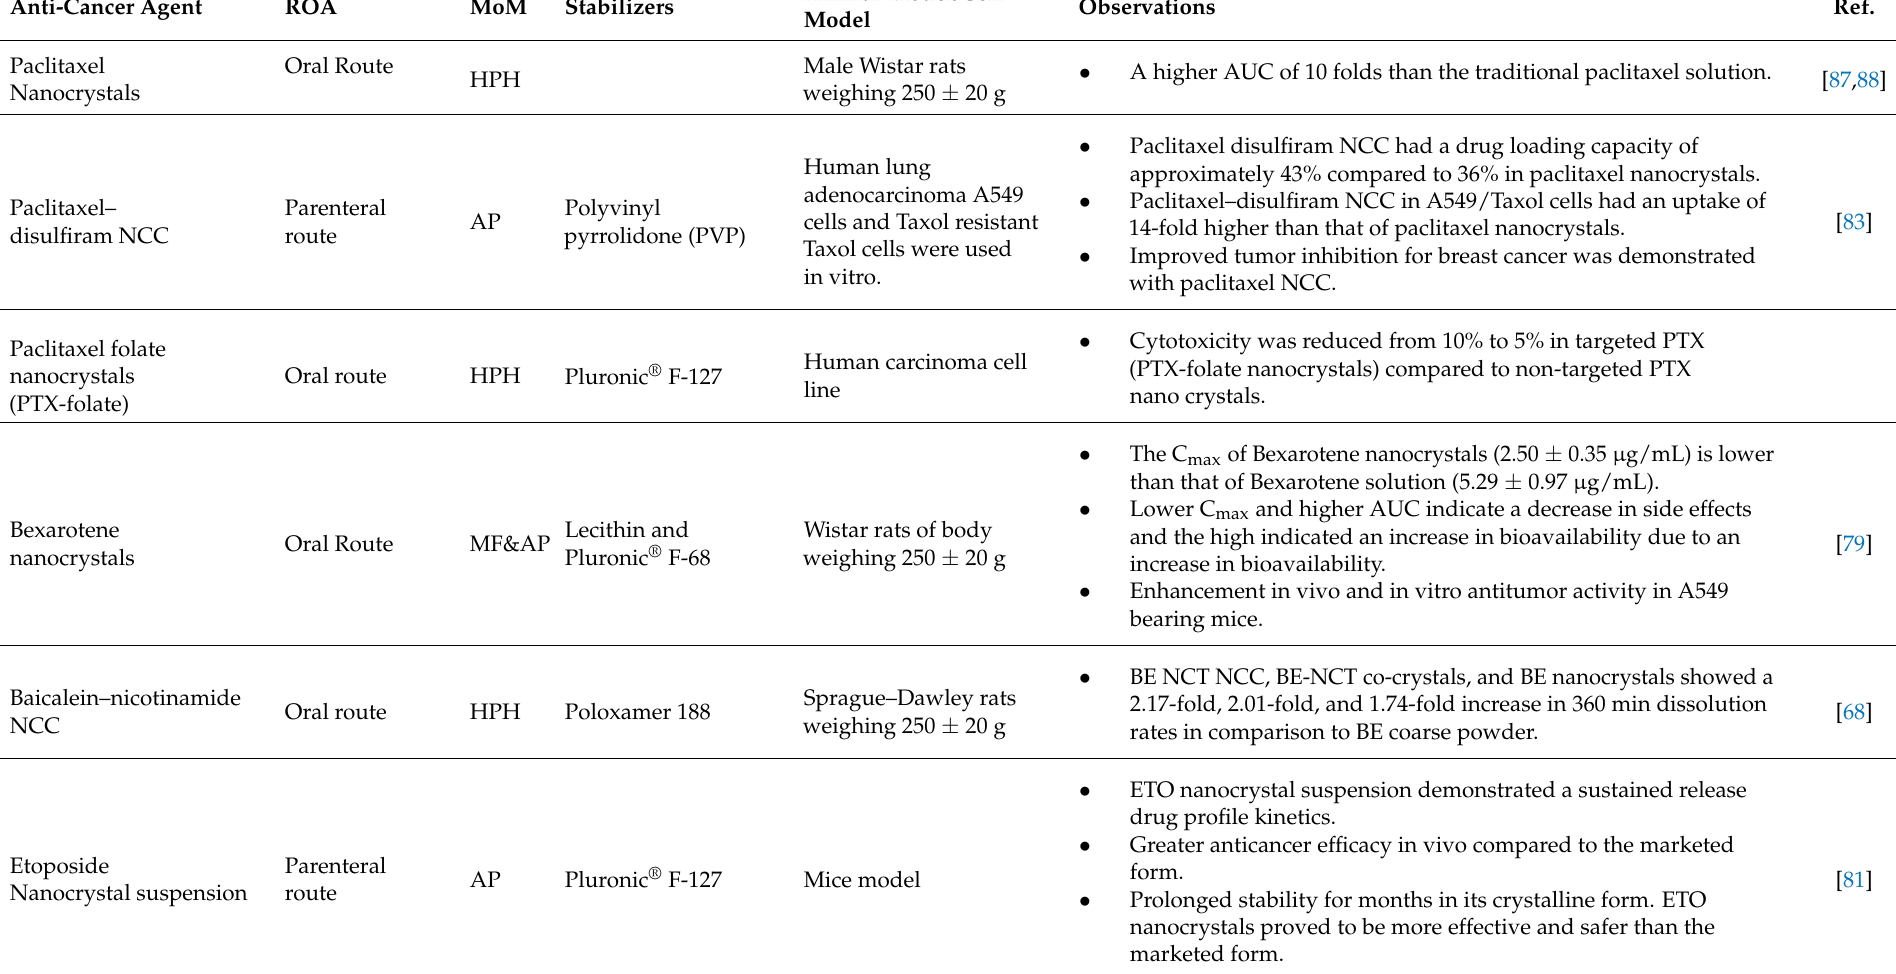
Table 3. Summary of the nanocrystals and NCC in the treatment of antineoplastic